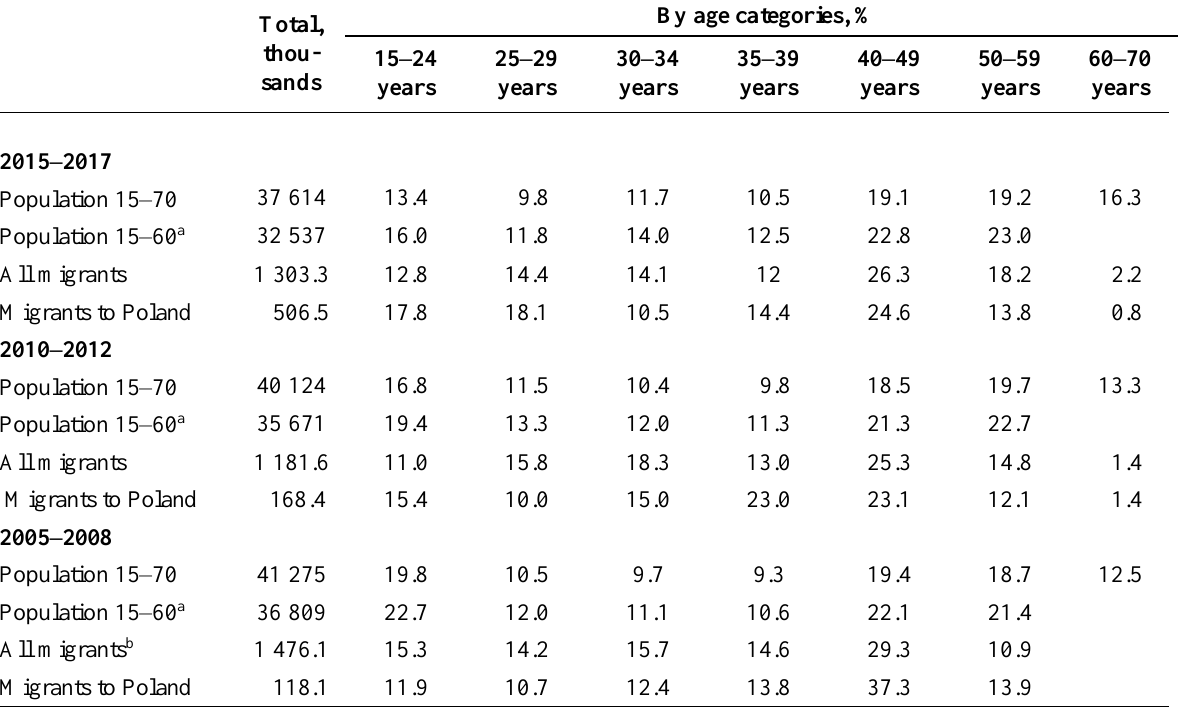
Table 1. Ukrainian labour emigrants and population by age cohorts, LFS